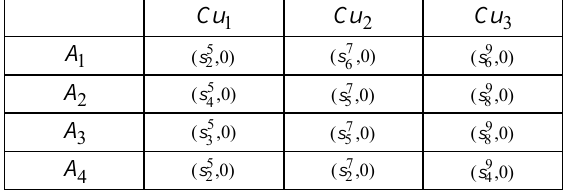
Table 6. Customers’ opinions about service quality